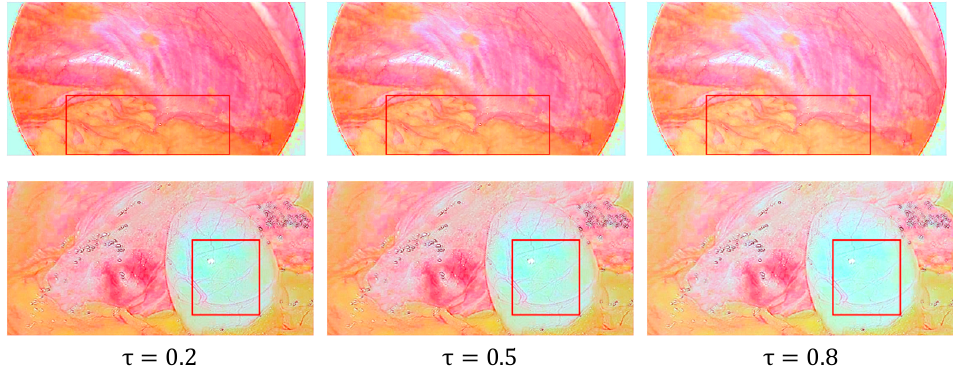
Figure 6. The reflection component enhancement results are obtained by setting different values of τ . Images in columns 1 and 3 suffer from visual discomfort or loss of detail, which are highlighted by red rectangles.